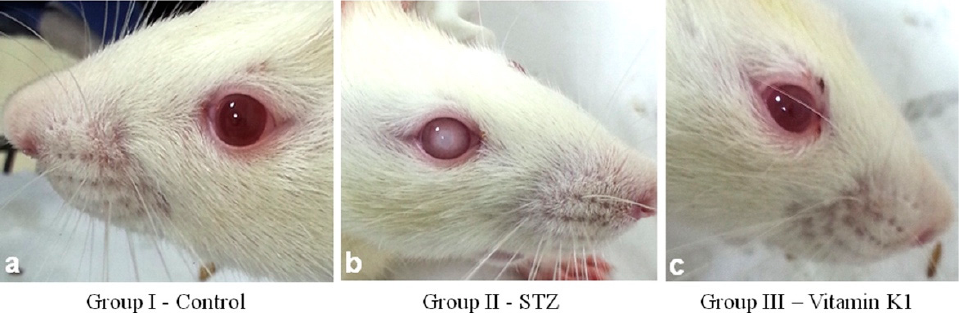
Figure 4. Effect of vitamin K1 on diabetic cataractogenesis. Control group I ( a ), cortical cataract observed in Group II STZ induced diabetes ( b ), treatment of diabetic rat with vitamin K1 prevented appearance of cataract in group III rats ( c ). Adapted from [129]. Copyright Elsevier-used with permission.